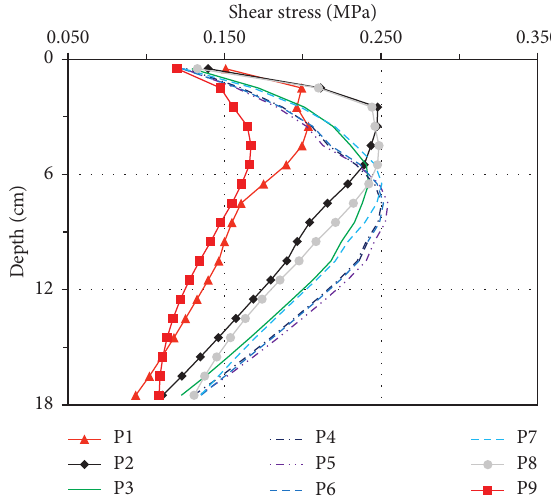
Figure 9: Distribution of shear stress at different